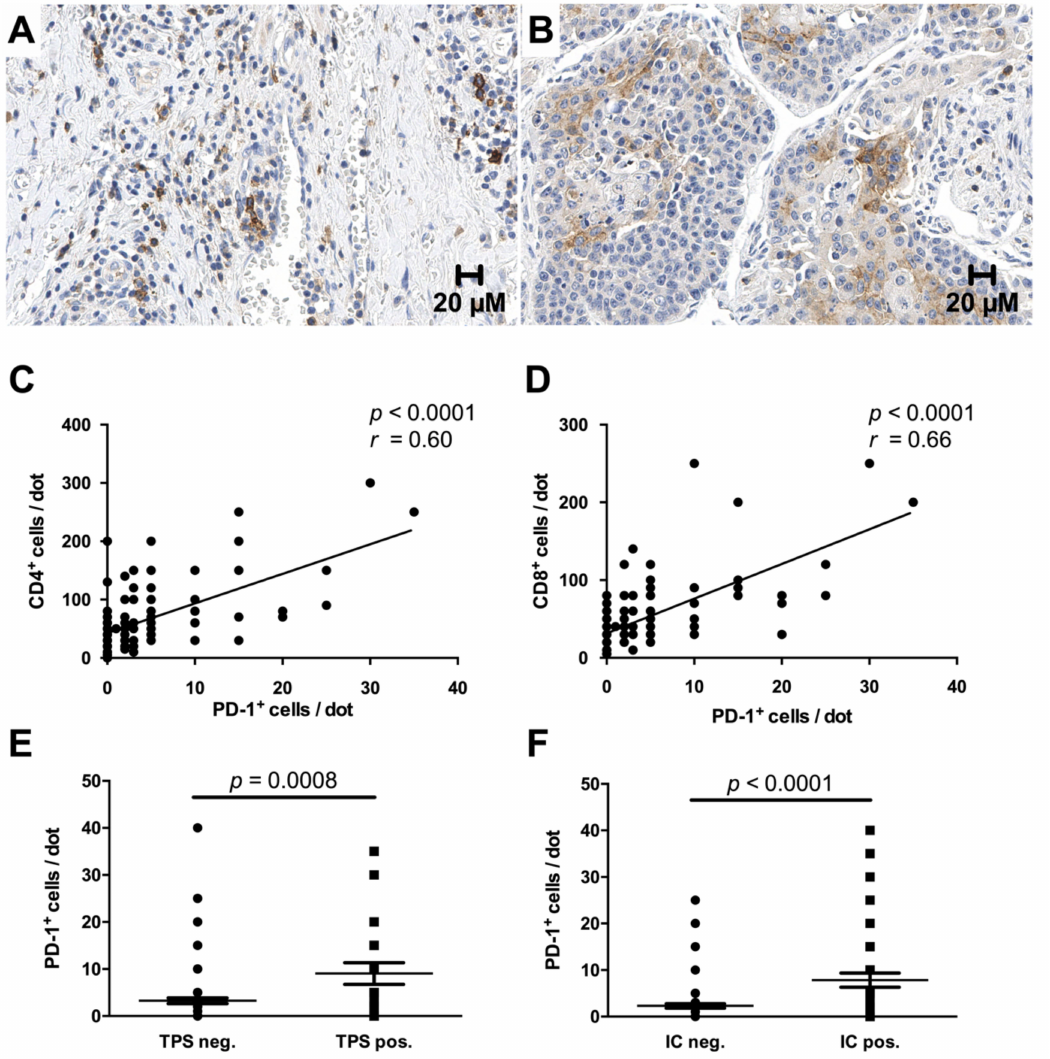
Figure 5. PD-1 + immune cells are increased in tumors with PD-L1 expression. More than half of the cases demonstrated strong membranous and cytoplasmic staining for PD-1 in a fraction of intra- and peritumoral immune cells ( A ), while positivity in the tumor epithelium was only detected in a single case with adenosquamous morphology ( B ). Co-expression of PD-1 and CD4 or CD8 was confirmed by correlation analysis ( C , D ). Furthermore, enhanced PD-1 expression was observed in cases with a Tumor Proportion Score (TPS) or Immune Cell score (IC) ≥ 1% ( E , F ). Original magnification in ( A , B ): 400 ×